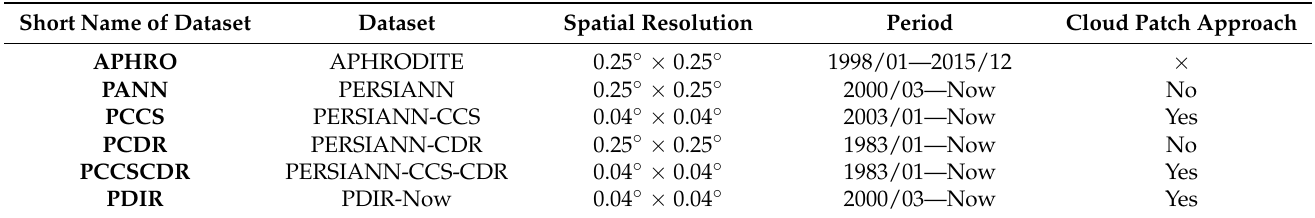
Table 1. The information regarding all precipitation datasets and the scheme regarding the algorithm attributes between the satellite precipitation products from the PERSIANN-series.